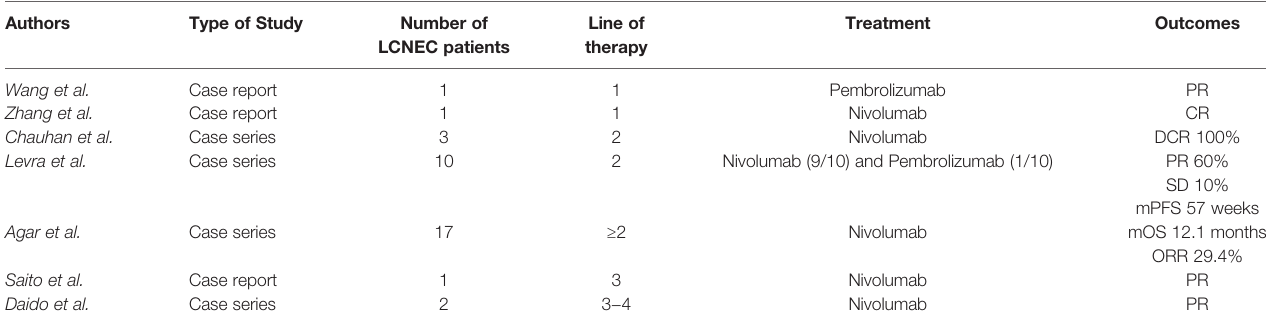
TABLE 4 | Immunotherapy data in LCNEC